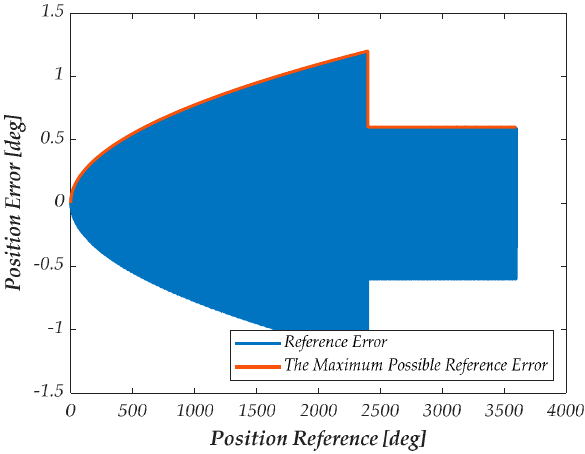
Figure 2. The position error and the maximum possible position error with the specific parameters.